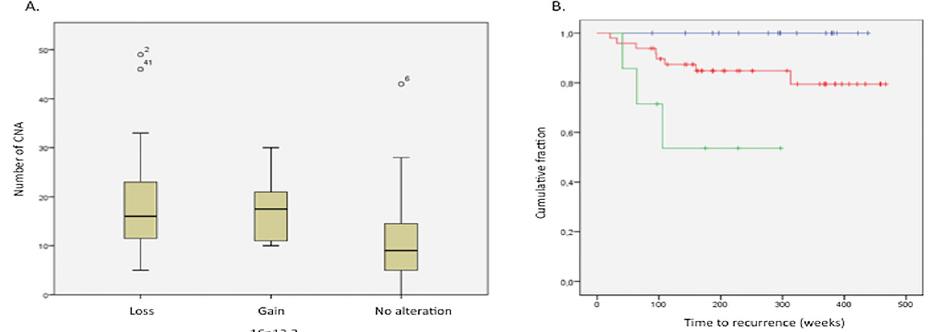
Fig 4. Gain of 16p13.3 is linked with a worse prognosis. (A) The relation of alteration of the 16p13.3 locus and the number of CNA in the corresponding patient for all tumour stages, R = -0,430 and *** P < 0,001. (B) Kaplan Meier survival curve showing a worse prognosis for patients with a gain of the 16p13.3 locus over all tumour stages, ** P = 0,010. Gains are represented in green, losses in blue and patients without an alteration are represented in